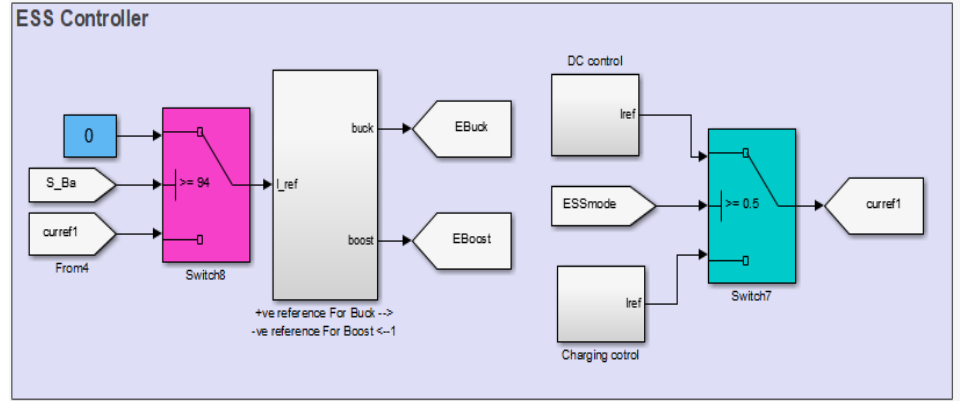
Figure A4. Control block diagram of the ESS.